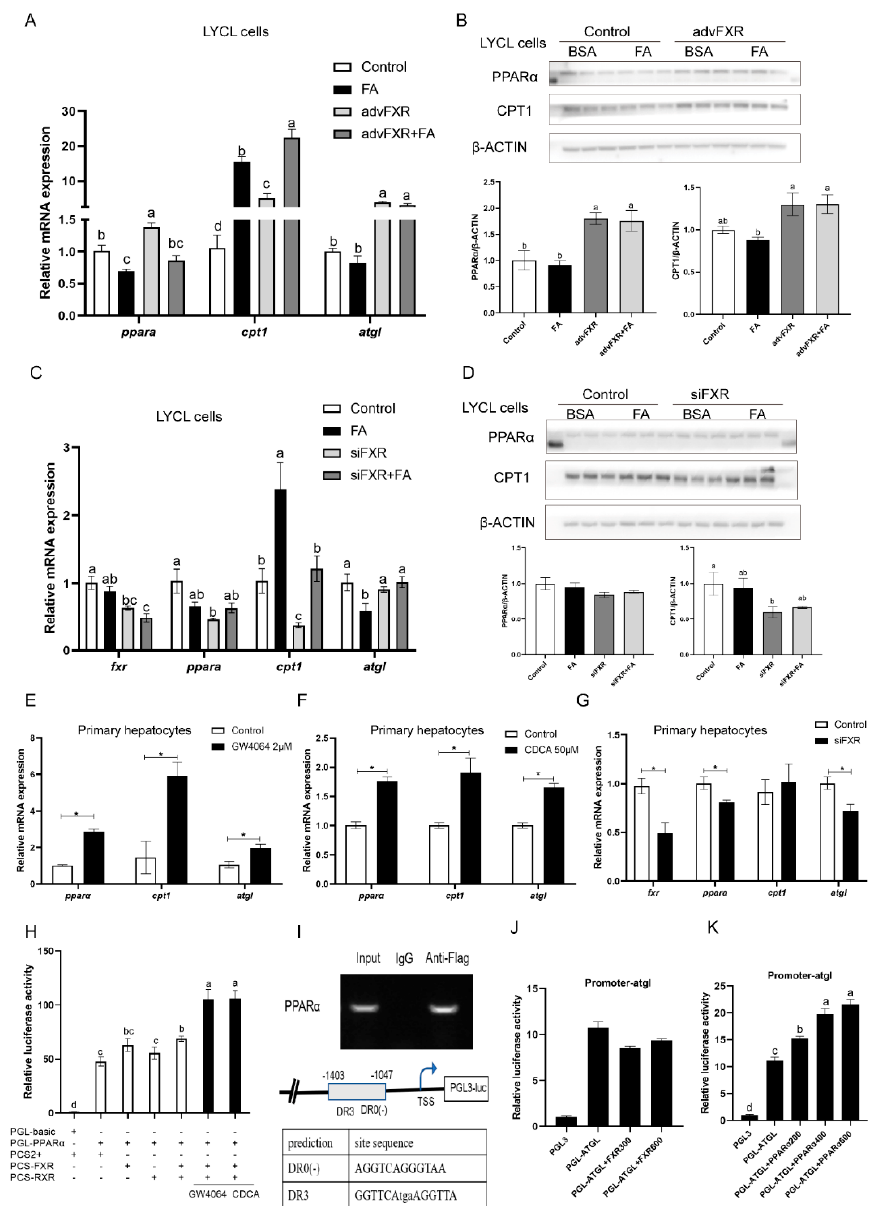
Figure 4. FXR affects genes involved in lipolysis and β -oxidation of large yellow croakers: ( A , B ) qRT-PCR assays or immunoblots for PPAR α , CPT1, and ATGL in LYCL cells after FXR overexpression and treatment with FA; ( C , D ) qRT-PCR assays or immunoblots for PPAR α , CPT1, and ATGL in LYCL cells after FXR knockdown and treatment with FA; ( E – G ) gene expression of ppar α , cpt1 , and atgl in primary hepatocytes after GW4064 or CDFA treatment or FXR knockdown; ( H ) promoter activity of croaker PPAR α in HEK 293T cells after FXR overexpression and treatment with FXR agonists; ( I ) ChIP analysis and identification of the FXR binding site in the croaker PPAR α promoter region; ( J , K ) promoter activity of croaker ATGL in HEK 293T cells after FXR or PPAR α overexpression. Data are shown as means ± SEMs ( n = 3) and were analyzed using Duncan’s multiple range test and Student’s t -test. The letters a–d indicate that there is a significant difference between means, * p < 0.05.